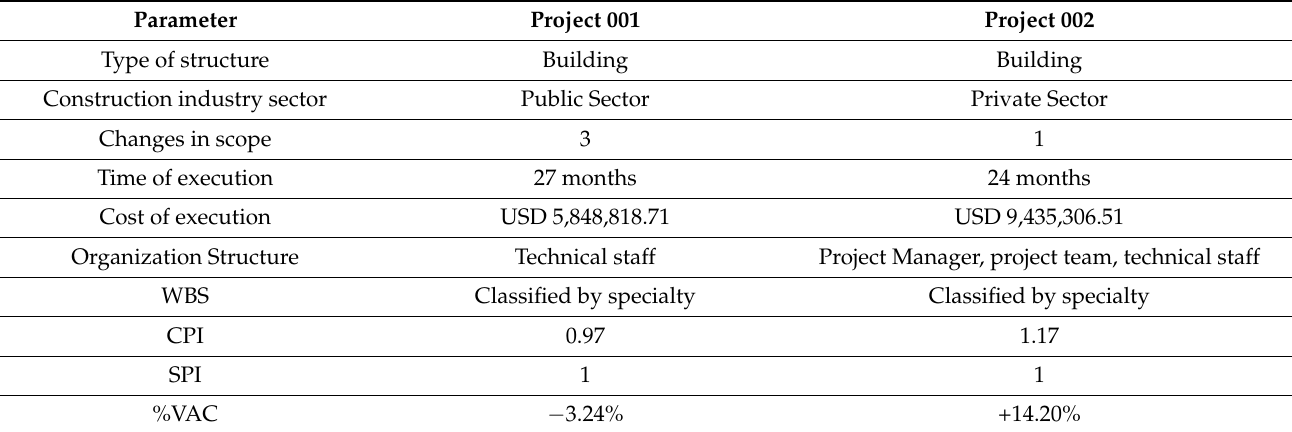
Table 5. Comparison between Project 001 and Project 002 (source: Proaño-Narv á